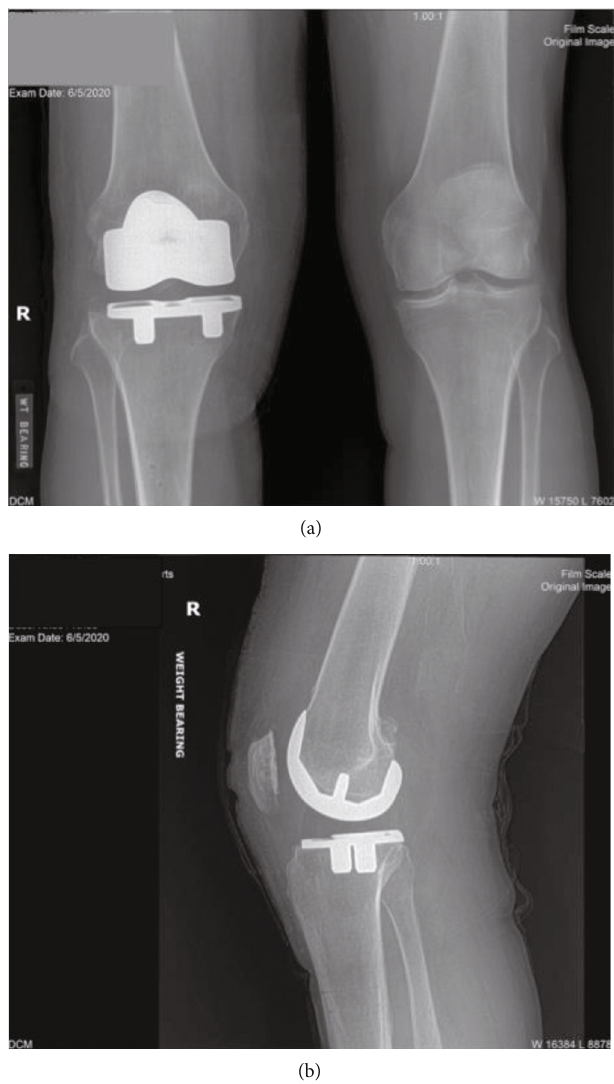
Figure 7: Postoperative weight bearing AP (a) and lateral (b) X-rays showing the fi nal alignment and joint spacing of the right knee for Case 2.